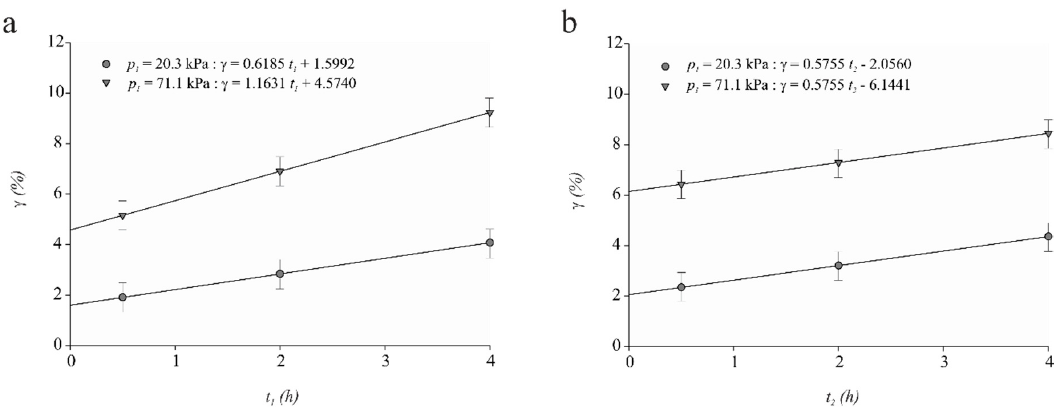
Figure 2. Mean ± SE ( n = 120) for final meat sample volume deformation ( (cid:2011) ) for both levels of vacuum